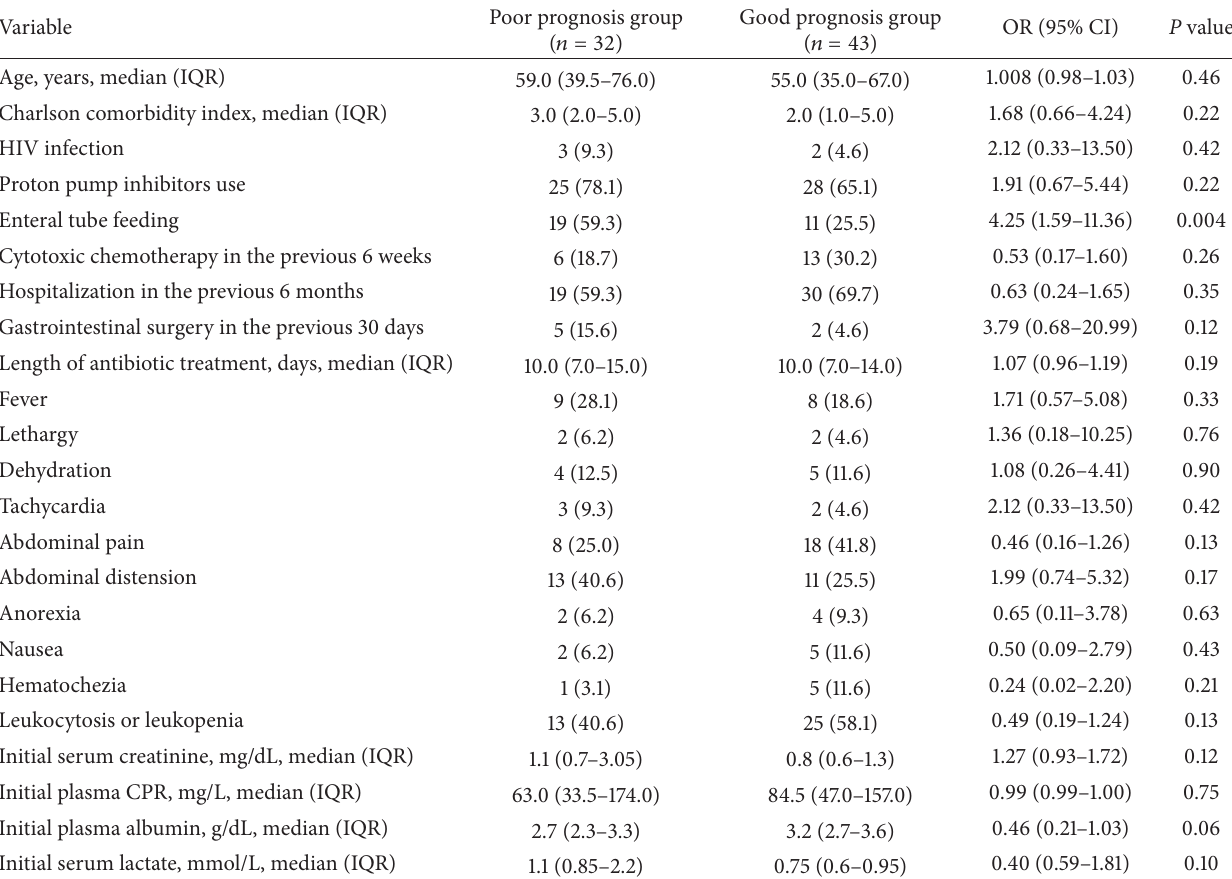
Table 4: Factors associated with poor prognosis ∗ among 75 hospitalized adult patients with Clostridium difficile colitis according to univariate logistic regression.